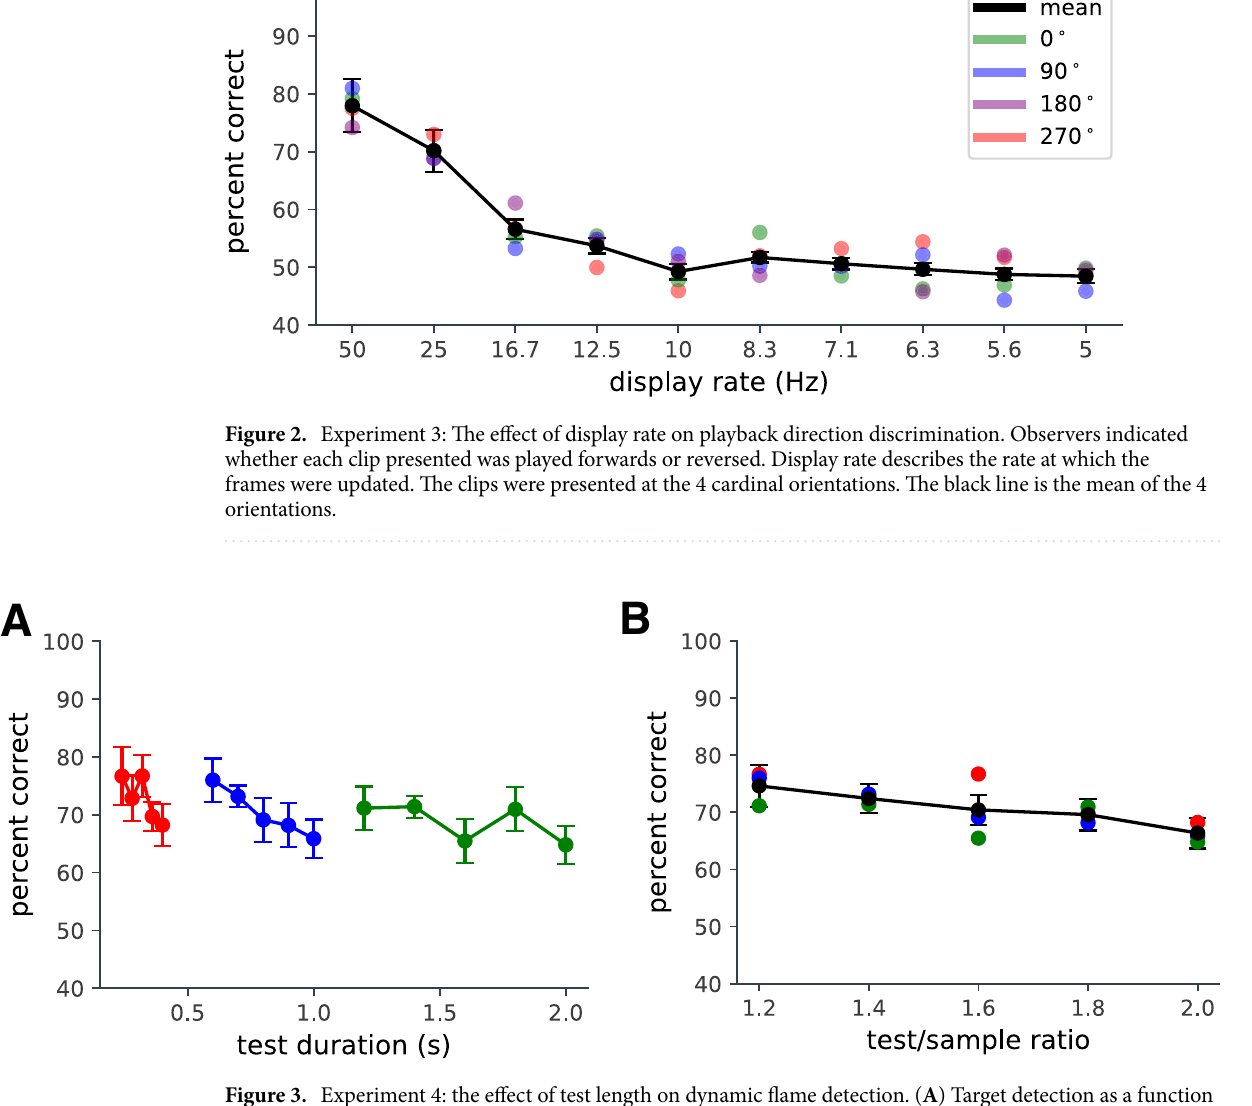
Figure 3. Experiment 4: the effect of test length on dynamic flame detection. ( A ) Target detection as a function of test duration for three test sample durations (red 0.2 s; blue 0.5 s; green 1 s). ( B ) Accuracy plotted as a function of test/sample